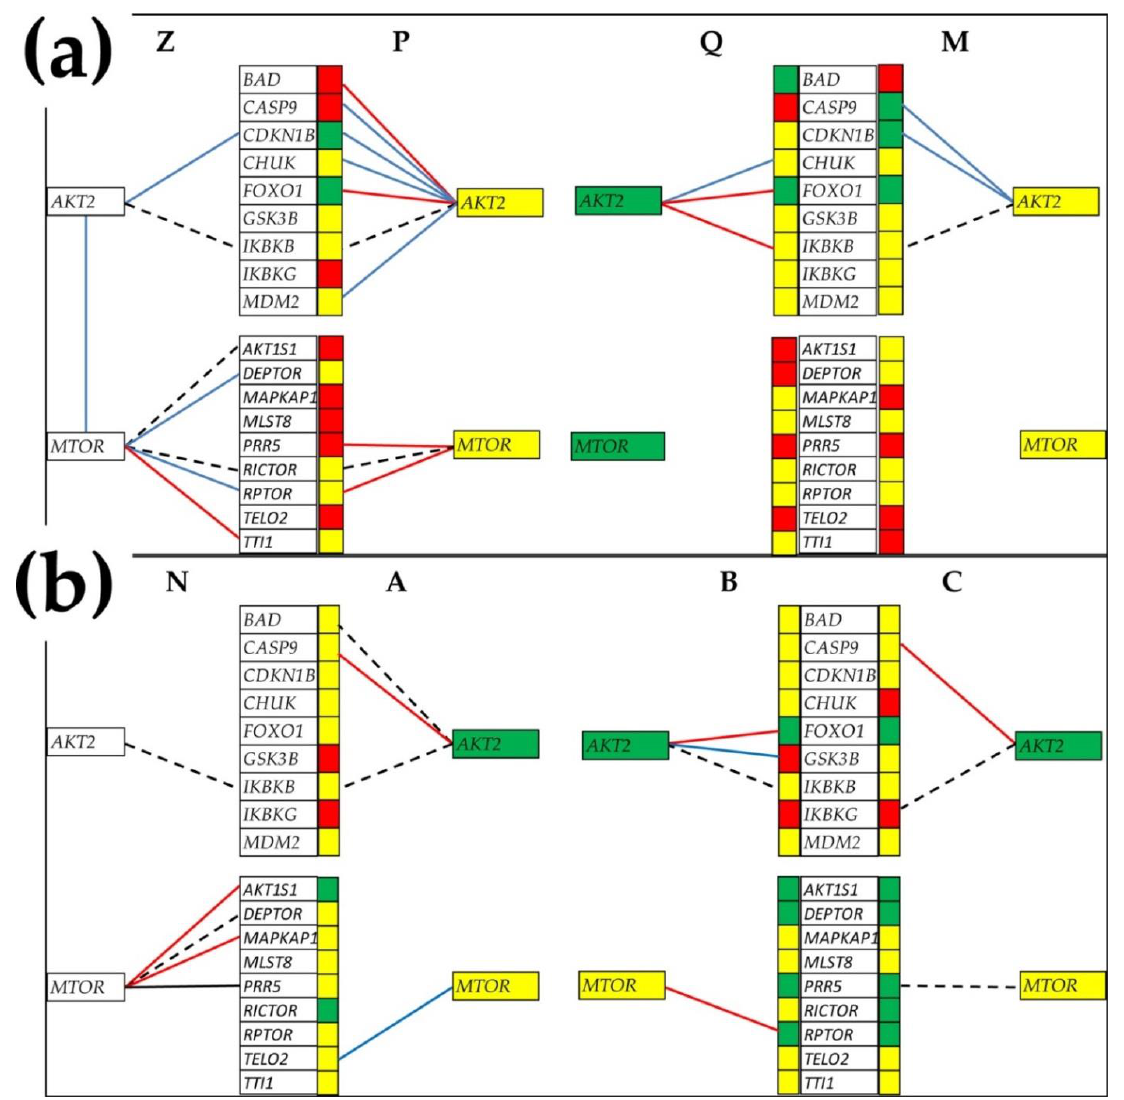
Figure 3. Expression coordinations of AKT2 with its partners, central to the prostate cancer devel- opment, and the coordinations of MTOR with its partners from mTORC1 and mTORC2 in the four profiled regions of the ( a ) “PQMZ” patient and ( b ) the “ABCN” patient. A continuous red/blue line indicates a statistically ( p < 0.05) significant synergistic/antagonistic expression of the linked gene, while a dashed black line indicates a statistically ( p < 0.05) significant independent expression of the paired genes. Missing lines mean lack of statistical significance of the expression coordination between the two genes. Red/green background specifies significant up/downregulation of that gene in the indicated cancer nodule (“P”, “Q”, “M”, “A”, “B” and “C”) with respect to the corresponding cancer-free surrounding tissue (“Z” or “N”), while yellow background means that the expression difference was not significant according to our composite criterion.